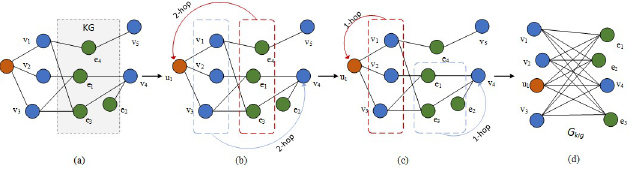
Fig 3. The reconstruction from knowledge graph to knowledge-enhanced interaction model. The orange circles are users, blue circles are items, and green circles are item attributes. Dash circles denote the user and its neighbors. The process from (b) to (c) demonstrate the high-order neighborhood information is propagated from 2-hop neighbors to 1-hop neighbors. (d) denote the final model, where the edges represent interaction among